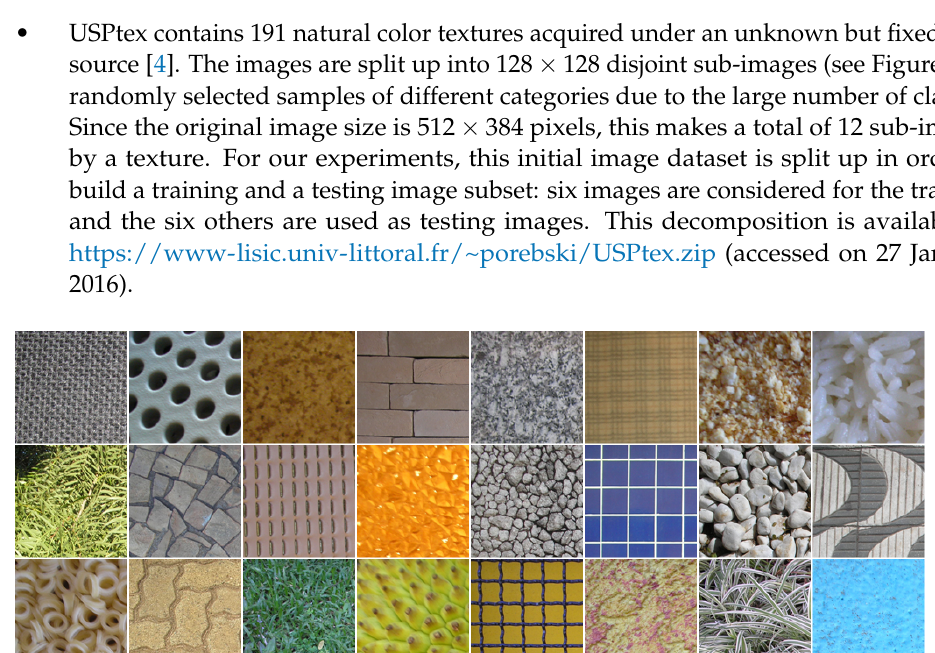
Figure 6. Samples illustrating the six tree bark color textures of the NewBarkTex2 dataset (from left to right: Betula pendula, Fagus silvatica, Picea abies, Pinus silvestris, Quercus robus, and Robinia pseudacacia).